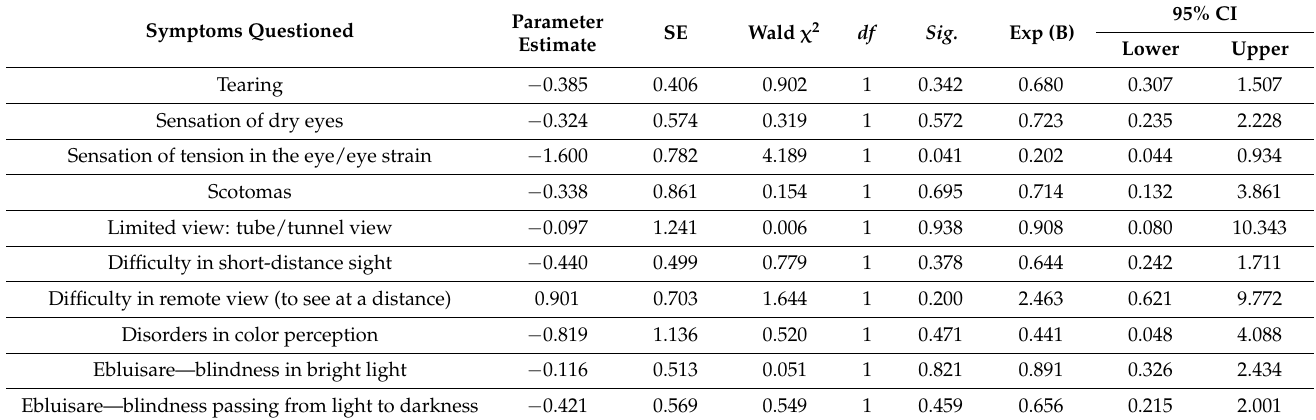
Table 15. Distribution of binomial logistic regression parameters to the symptom questionnaire in the POAG and NTG